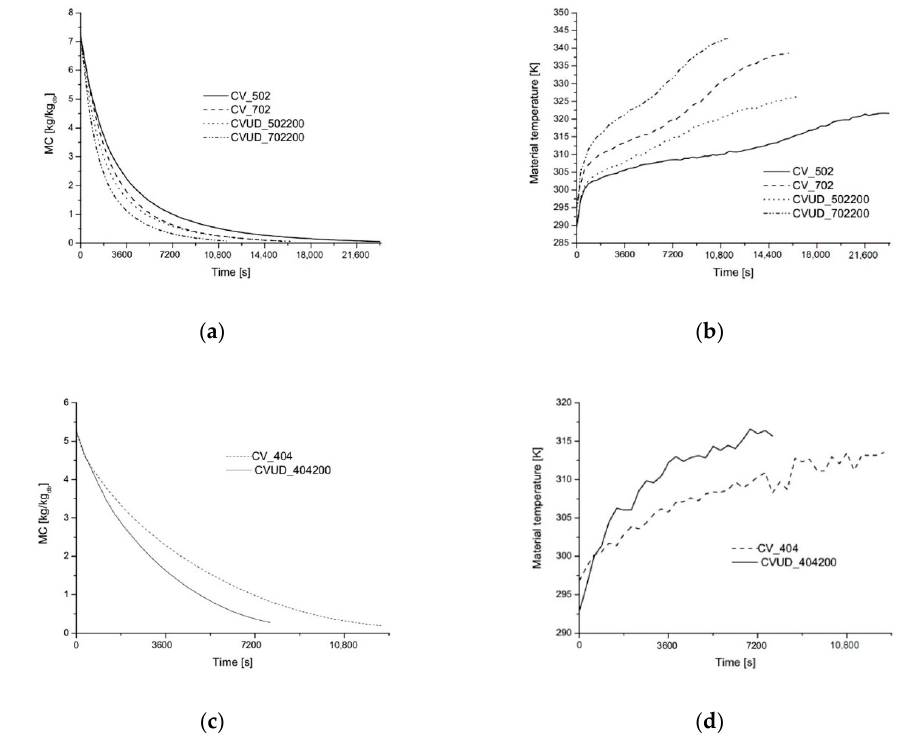
Figure 3. Drying kinetics of the ultrasound-assisted convective drying of carrot samples: ( a ) Drying curves and ( b ) temperature evolution curves. Drying kinetics of the ultrasound-assisted convective drying of apple samples: ( c ) Drying curves and ( d ) temperature evolution curves.